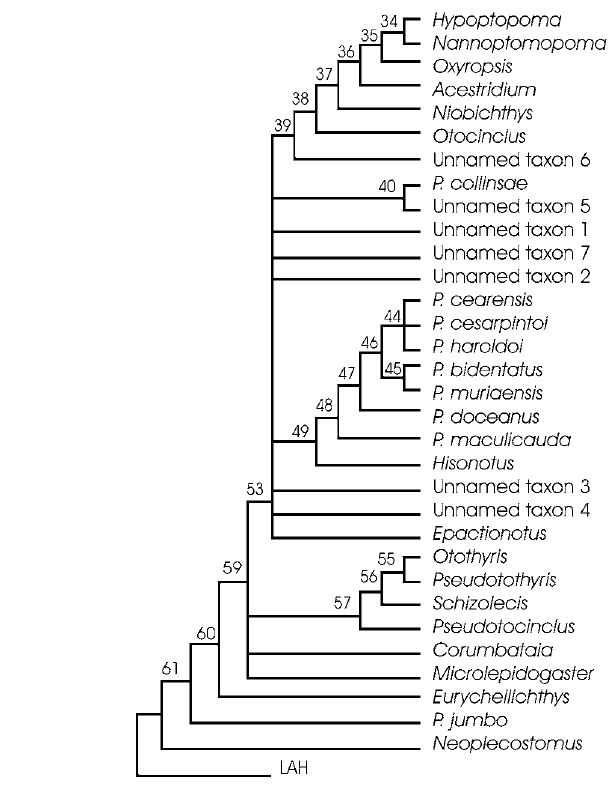
Fig. 3. Consensus cladogram of 153 most parsimonious hy- potheses of Hypoptopomatinae relationships. See Compara- tive Material of a complete list of specimens representing each taxon. Numbers correspond to clades in Fig. 2. P. = Parotocinclus.